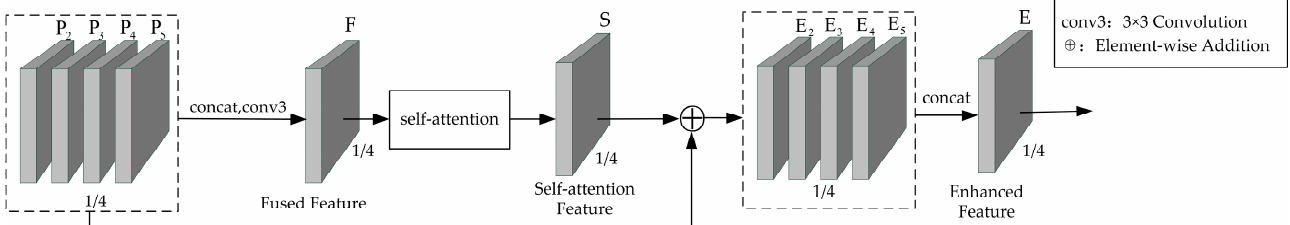
Figure 2. Module of feature enhancement.